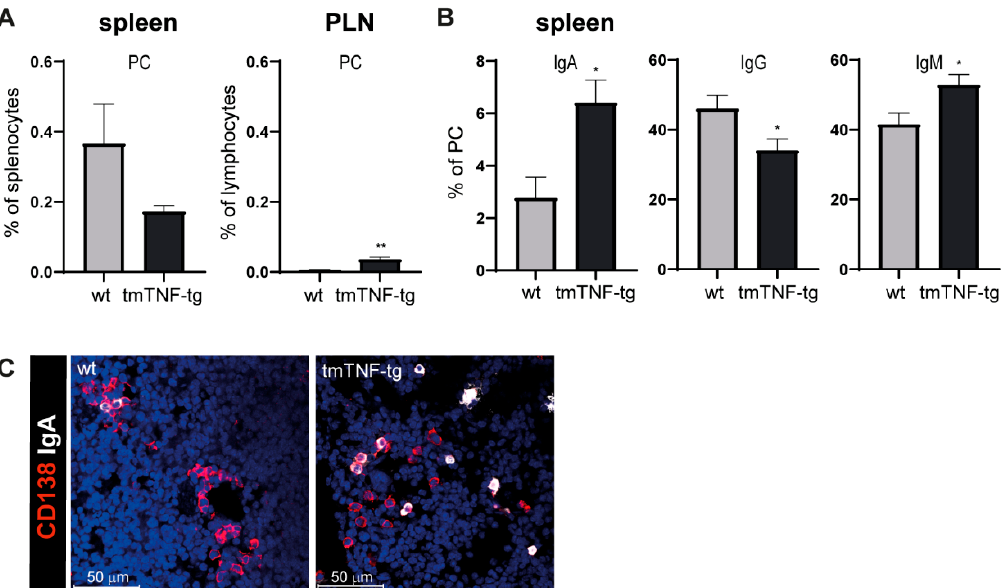
Figure 3. Increase in IgA and IgM plasma cell proportions in the spleen of tmTNF-tg mice. PC populations were analyzed using flow cytometry and immunofluorescent staining. ( A ) PC proportions in the spleen and PLNs of tmTNF-tg mice. ( B ) Analysis of PC Ig-classes in spleen samples. IgA + and IgM + PC populations were increased in the spleen of tmTNF-tg mice. ( C ) Representative image of an immunofluorescent staining of spleen sections. IgA + PC were increased in the spleen of tmTNF-tg mice. PC = plasma cell; Ig = immunoglobulin; CD138 + = marker for PC; * = p ≤ 0.05; ** = p ≤ 0.01; n = 6 for all graphs.